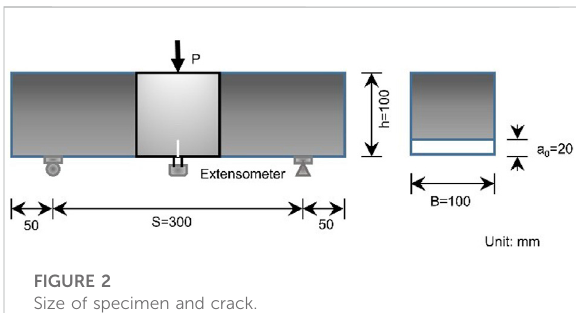
FIGURE 2 Size of specimen and